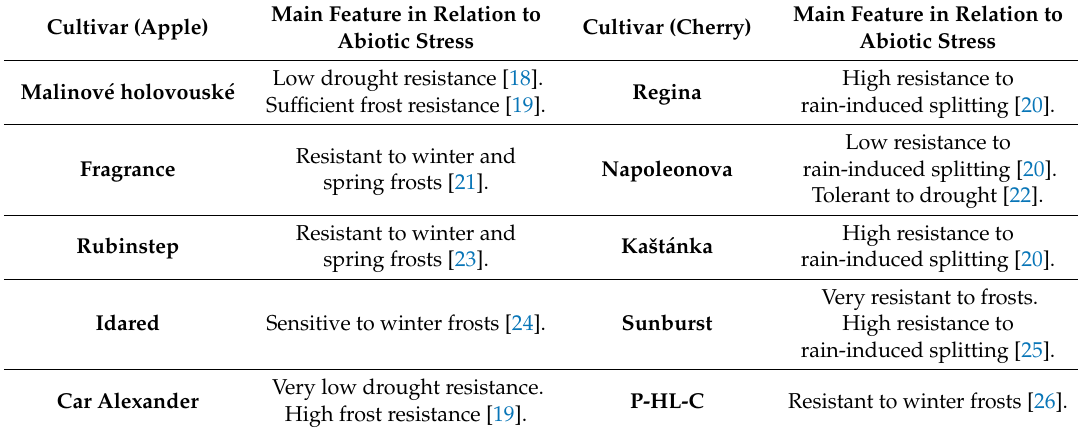
Main Feature in Relation to Cultivar (Cherry) Abiotic Stress High resistance to Regina rain-induced splitting [20]. Low resistance to Napoleonova rain-induced splitting [20]. Tolerant to drought [22]. High resistance to Kašt á nka rain-induced splitting [20]. Very resistant to frosts. High resistance to rain-induced splitting [25]. P-HL-C Resistant to winter frosts